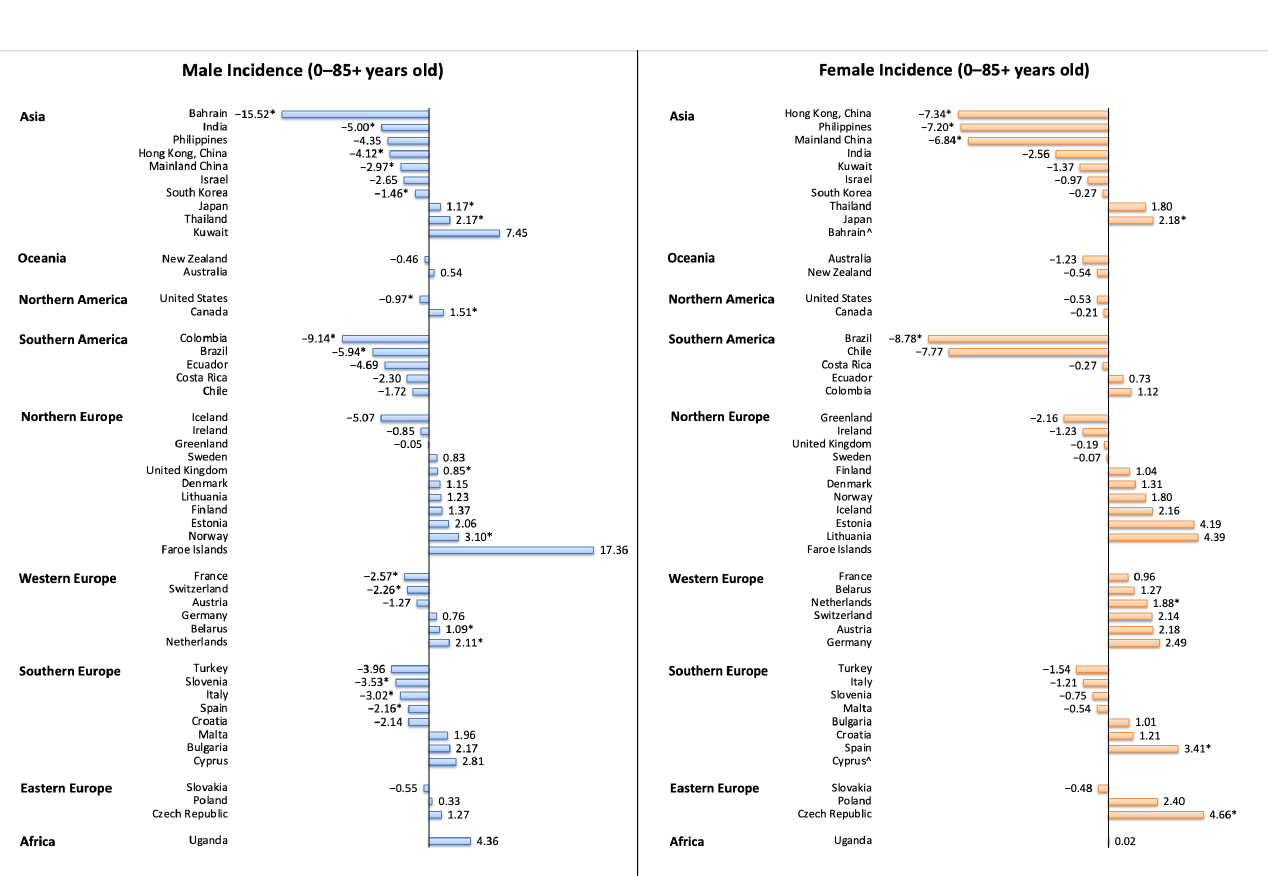
Figure 4. The AAPC of the incidence of esophageal cancer in individuals aged 0–85+ years. AAPC, annual percentage change; * p values less than 0.05; ˆ AAPC for these countries could not be generated, as zero or missing values were identified in any year of trend analysis; the 95% confidence intervals and p values for the tests of AAPC are presented in Table